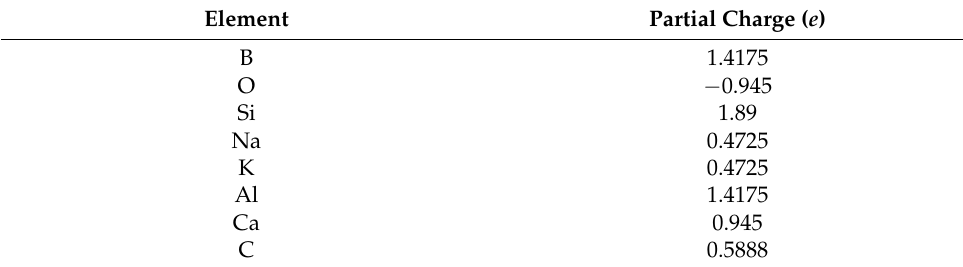
Table 7. Fixed elemental partial charge